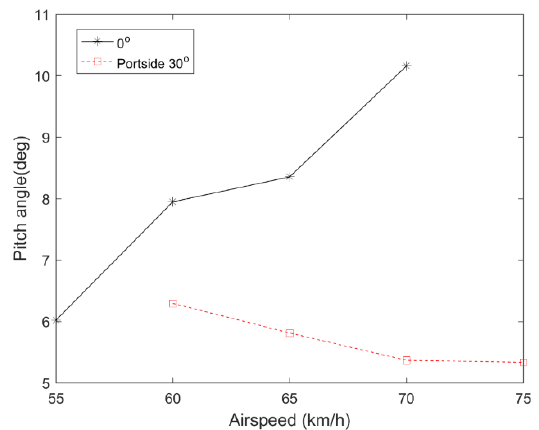
Figure 17. Trim pitch angle under 0° and portside 30° WOD conditions.